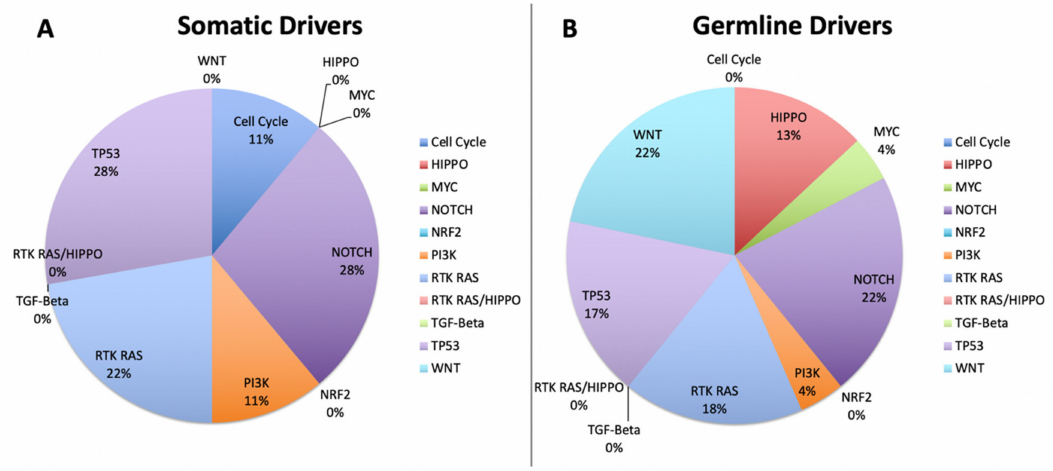
Figure 7. Analysis limited to only variants predicted to be driver mutations, 22% of germline variants are in the WNT signaling pathway and 13% in the Hippo pathway, with no somatic driver variants